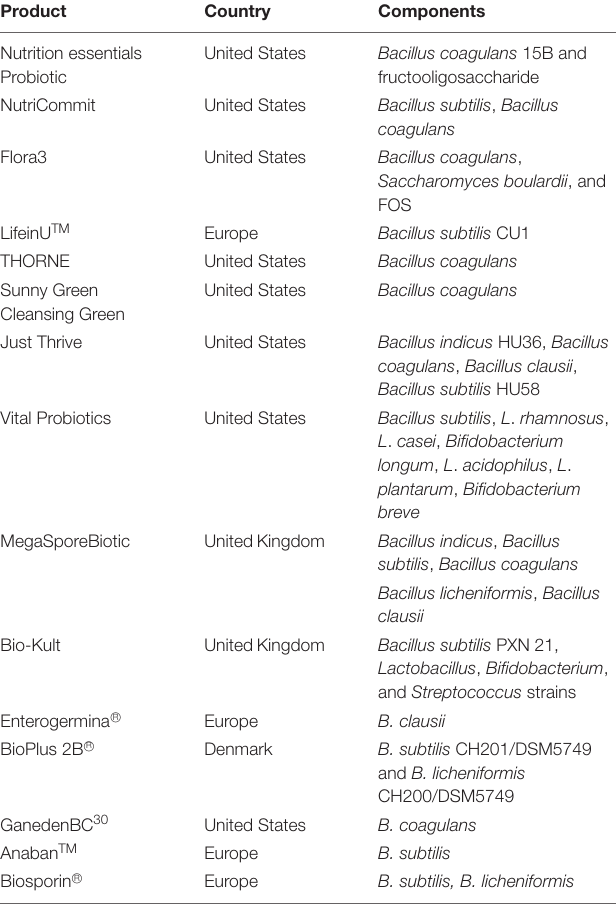
TABLE 1 | Examples of probiotic supplements containing Bacillus spp. available in global